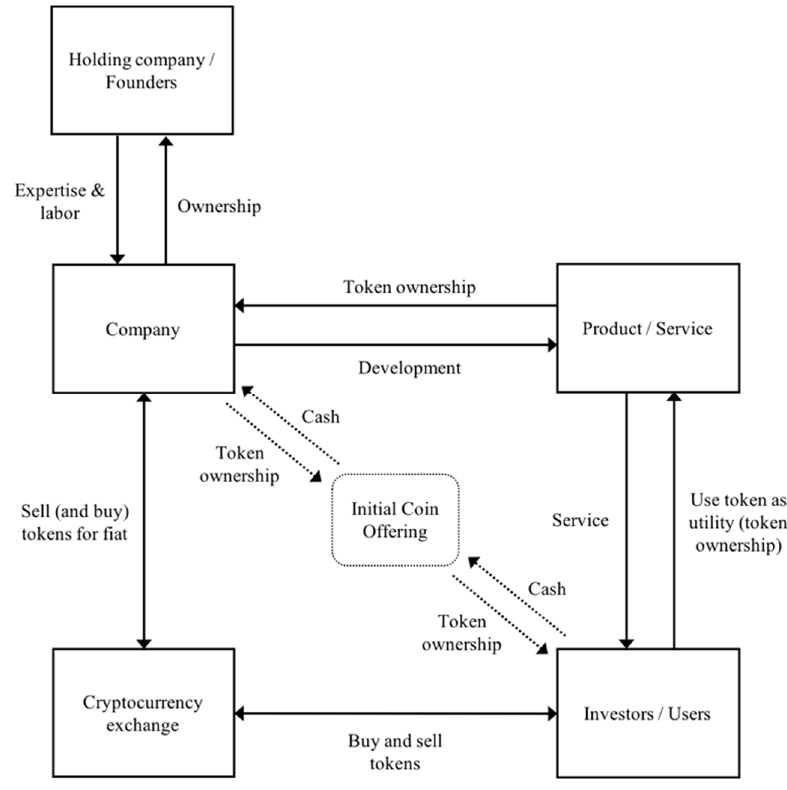
Figure 1. Token-based economy and initial coin offering (ICO).